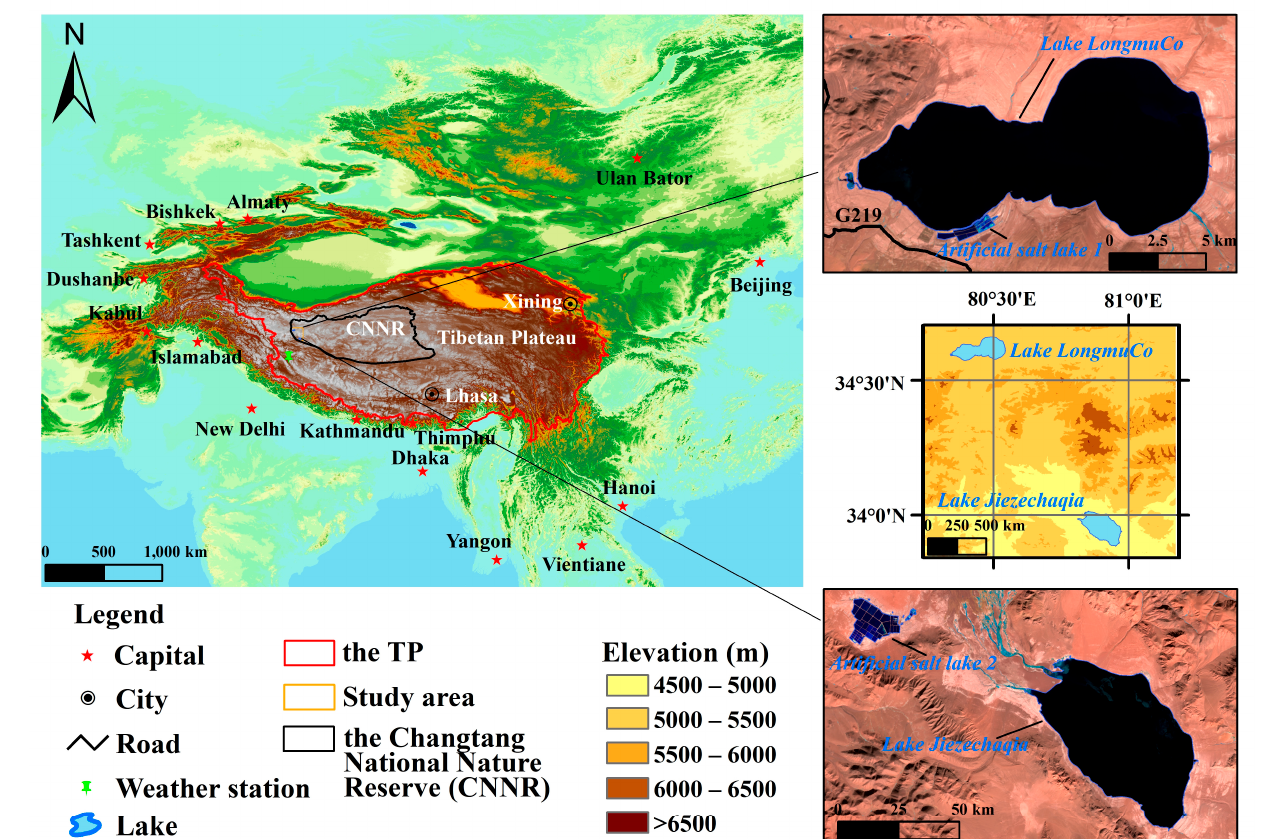
Figure 1. Locations of Lake LongmuCo and Lake Jiezechaqia and their surrounding topography.